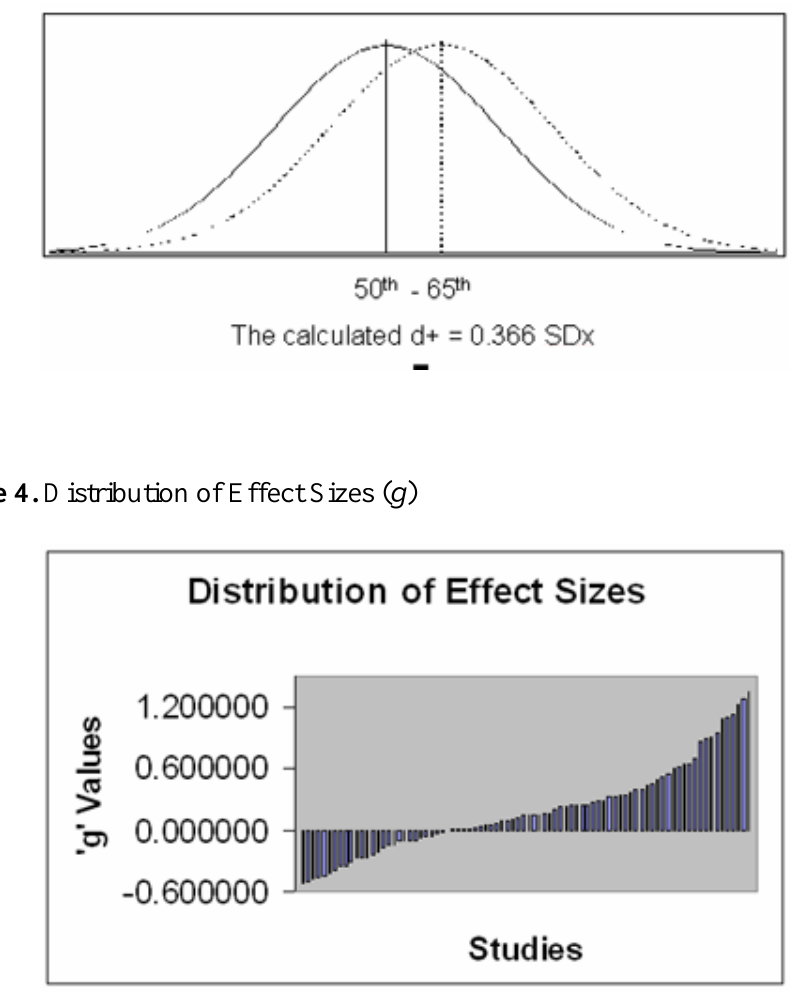
Figure 3. Percentile of F2F Group Distribution